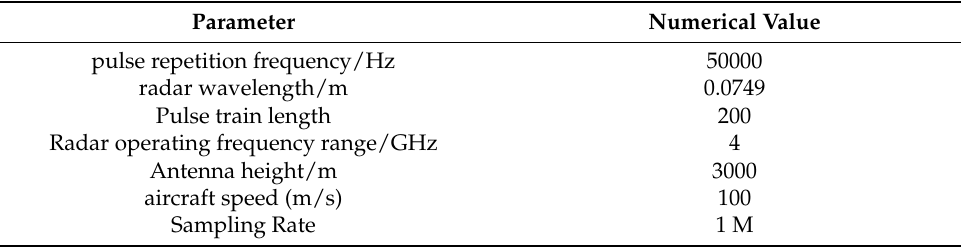
Table 11. Radar system parameters.